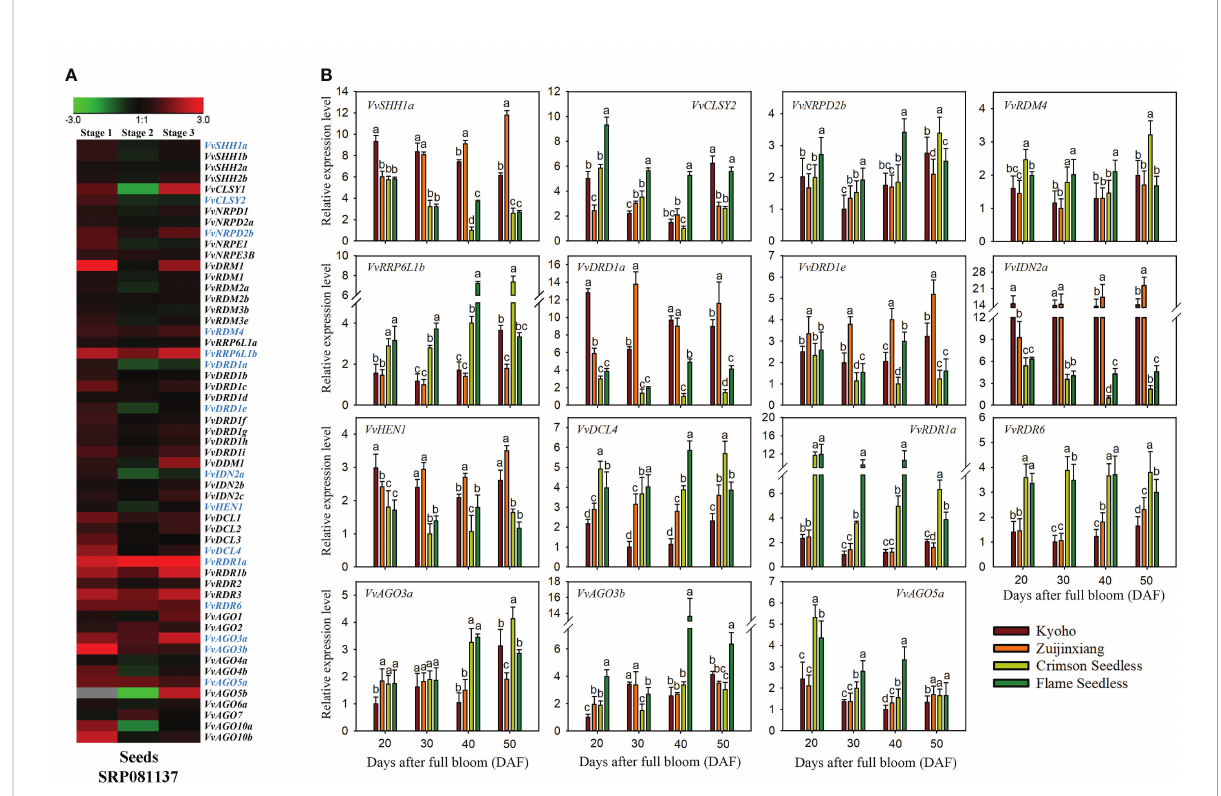
FIGURE 10 Transcriptomic and expression analysis of grapevine VvRdDM genes during seed development. (A) Heat map of grapevine VvRdDM genes in seeded and seedless progenies during seed development, transcriptome data were downloaded from the NCBI SRA datasets (SRP081137). Data were normalized by log 2 the ratio of TPM (seedless/seeded) of each gene during the all three stages. The red and green boxes indicate the relatively high and low expression levels of each gene, respectively. (B) qRT-PCR analysis of VvRdDM genes in four cultivars during seed development. Different cultivars are denoted with different colors. Different letters denote statistically signi fi cant differences (ANOVA with a Tukey post-hoc analysis, 5% level). The mean ± S.D. of three biological replicates are